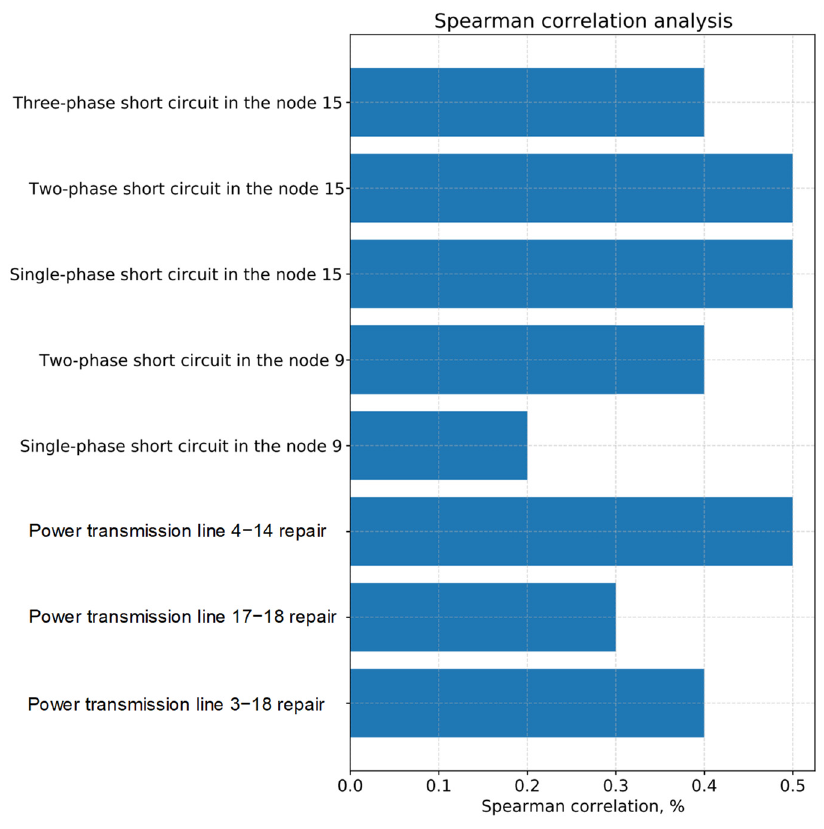
Figure 3. The results of data correlation analysis.